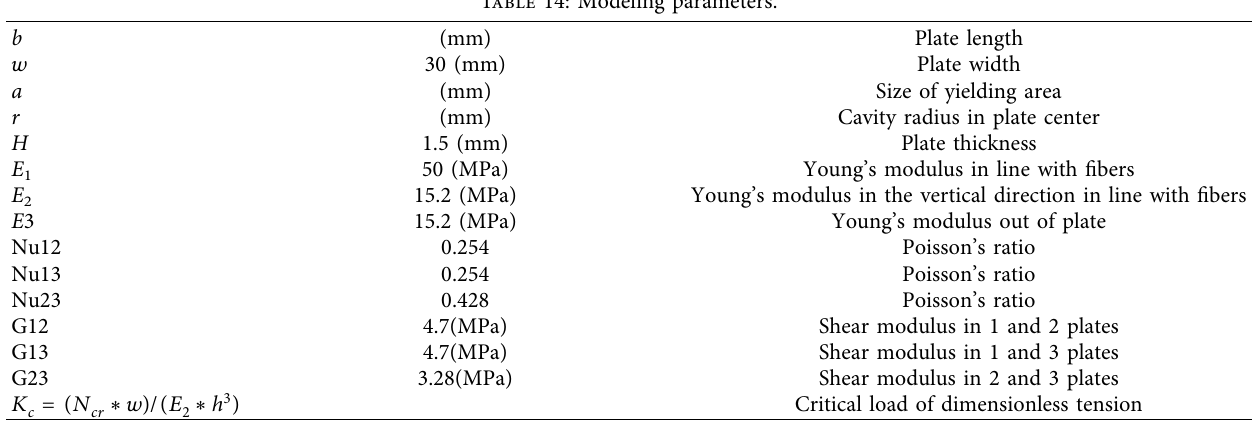
Table 14: Modeling parameters.